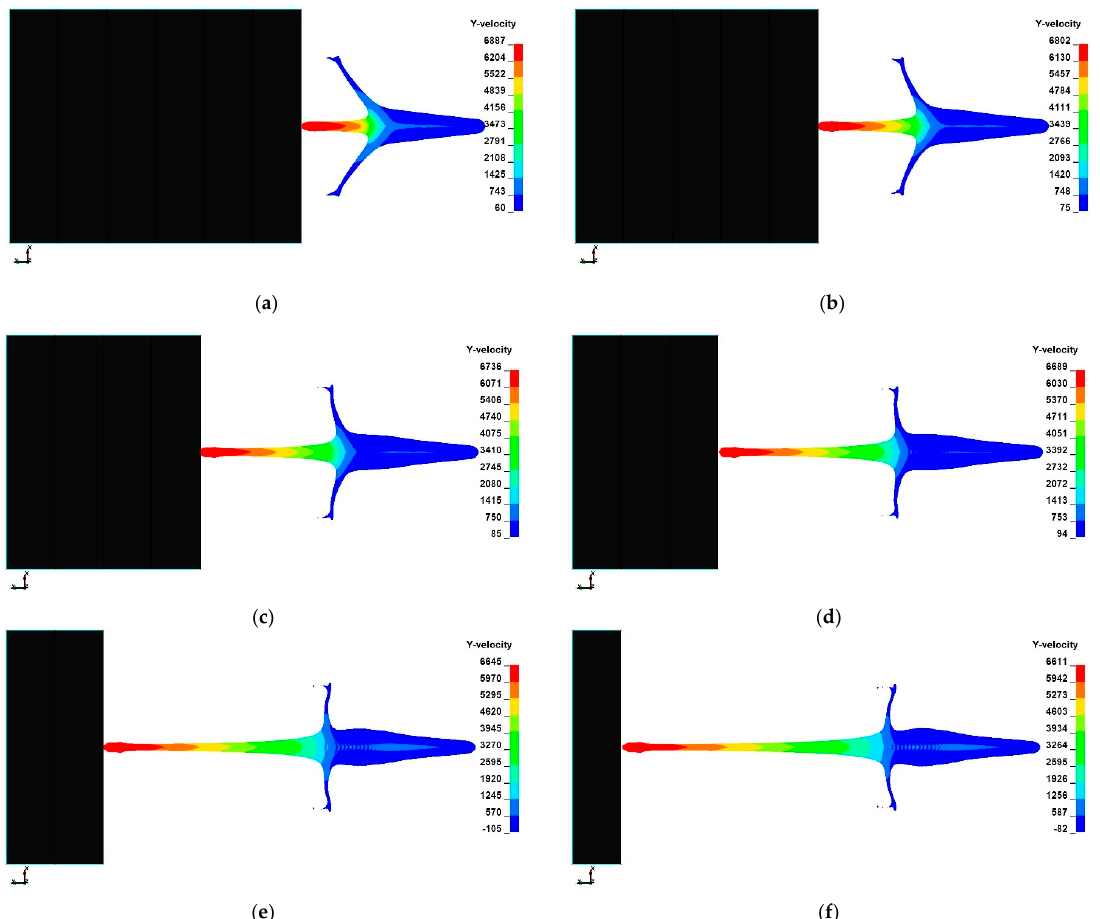
Figure 6. View of the shaped charge jet with the marked map of the resultant velocity at the moment of contact with the target: ( a ) 7.5 mm standoff, ( b ) 20 mm standoff, ( c ) 32.5 mm standoff, ( d ) 45 mm standoff, ( e ) 57.5 mm standoff and ( f ) 70 mm standoff.